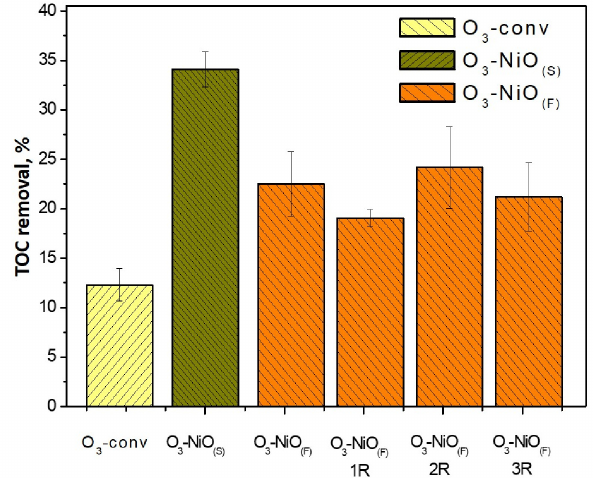
Figure 8. TOC removal (%) in conventional and catalytic ozonation and the effect of reusing films during three cycles with 10 films of NiO